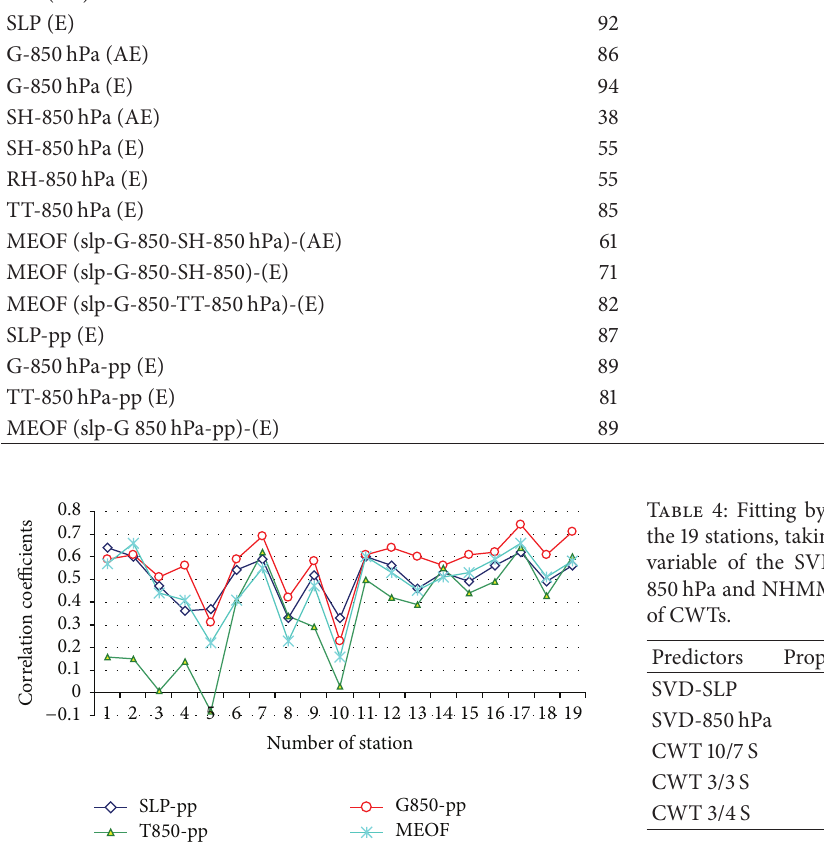
Figure 4: Correlation coefficients between observed and simu- lated mean spring precipitation by NHMM taking into account atmospheric predictors (first 10 PCs) for MEOF decomposition of two pairs of fields: atmospheric over the European region (E) and precipitation at the 19 stations.